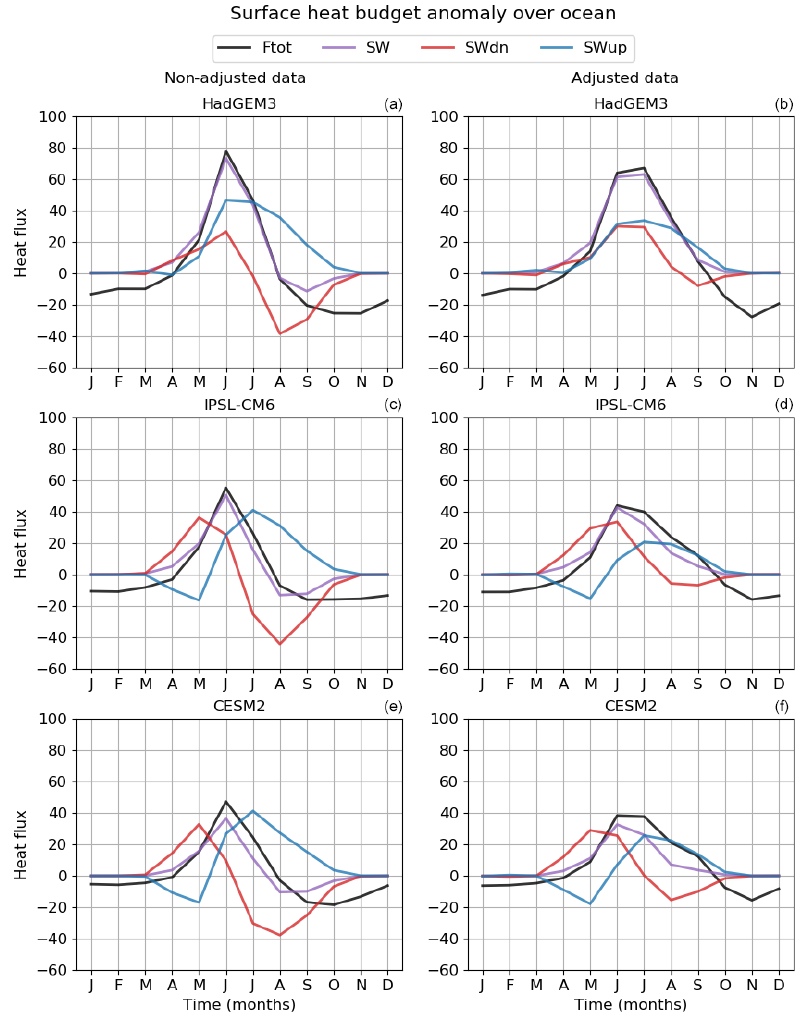
Figure 8. The main components of the atmospheric energy budget at the surface averaged over the Arctic (70–90 ◦ N) for HadGEM3, CESM2 and IPSLCM6. The LIG–PI anomalies as shown as a function of the month for the total energy budget (Ftot, black), the SW budget (SW, violet), and for the downward (SWdn, red) and upward SW (SWup, blue) fluxes. The sign convention for all fluxes is that fluxes pointing downward are positive and fluxes pointing upward are negative. Panels (b) , (d) and (f) show results for which the LIG calendar has been taken into account (for the LIG simulations), while panels (a) , (c) and (e) show the results averaged on the PI calendar both for PI and